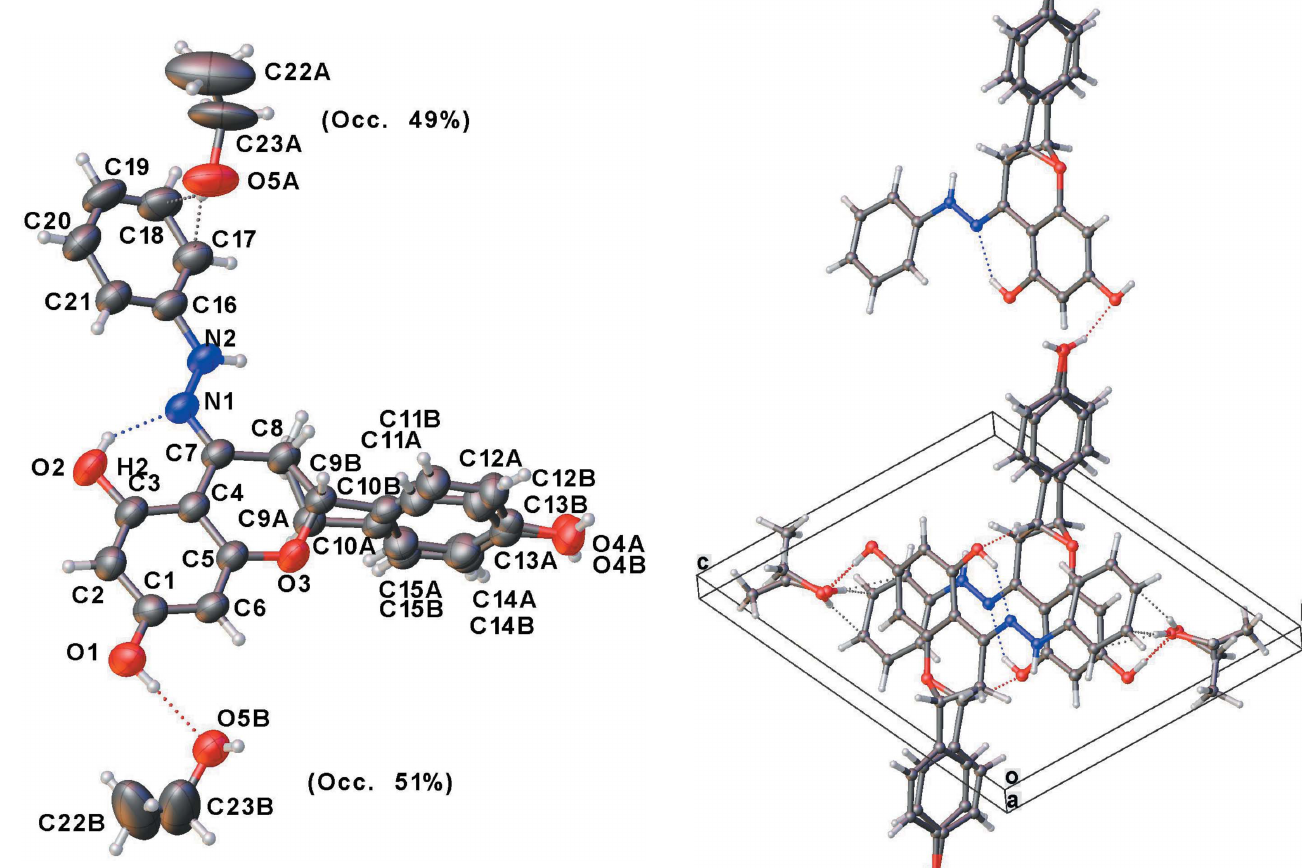
Figure 1 Displacement ellipsoid drawing at 50% probability level of the asymmetric unit showing the superposition of two enantiomers in the asymmetric unit. The disorder in the solvent (ethanol) molecule is resolved here, shown in two partial-occupancy